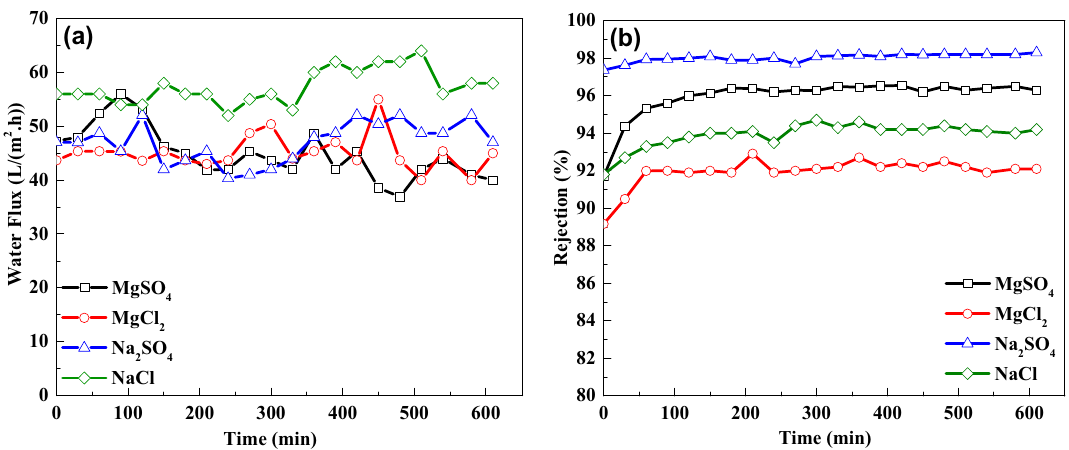
Figure 15. Long-term stability ( a , b ) of 0.3 wt.% TFN-Al 2 O 3 membrane (with 2 g/L inorganic salt aqueous solutions at 10 bar).